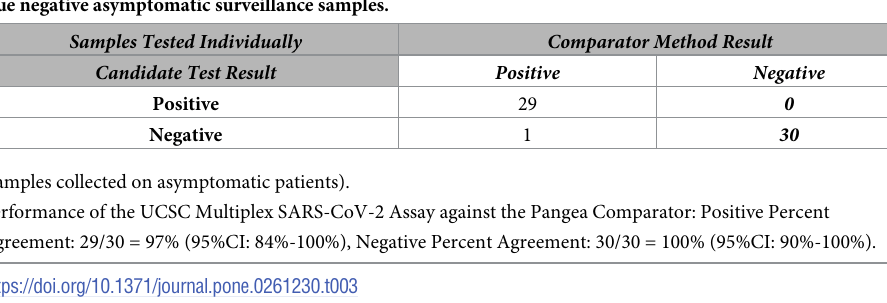
Table 3. Validation of UC Santa Cruz Multiplex SARS-CoV-2 assay by a commercial lab using true positive and true negative asymptomatic surveillance samples. Samples Tested Individually